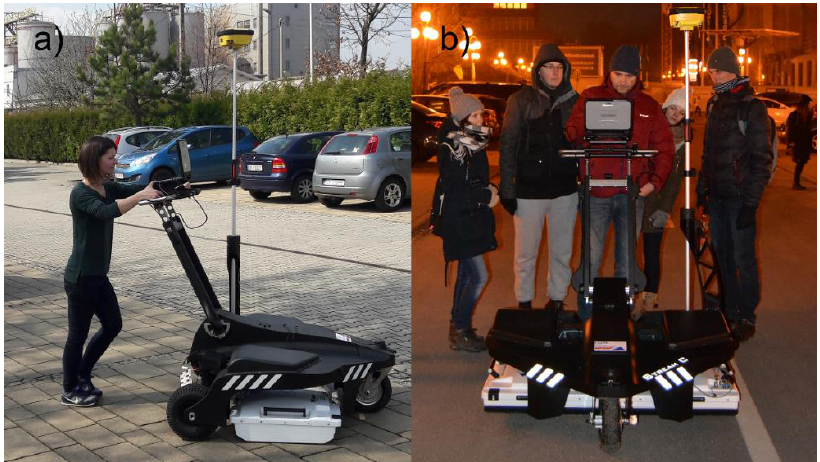
Figure 2. Ground Penetrating Radar (GPR) Leica Stream C: ( a ) during test measurement; ( b ) in urban area.